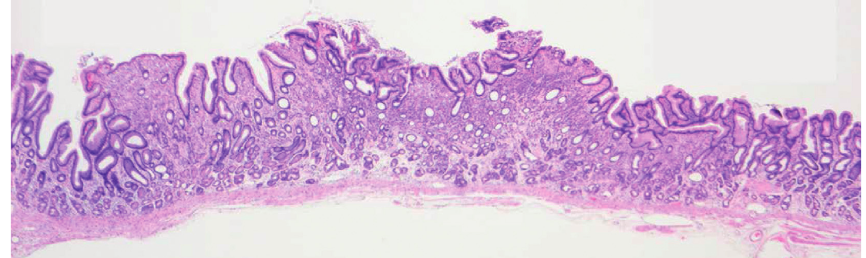
Figure 2: Cancer cells seen mainly invading the height of the glandular neck zone, with none in the deep mucosa. There is neither erosion of the surface epithelium nor any signs of tumor cell exposure on the surface. This is a flat-elevated lesion proliferating within the